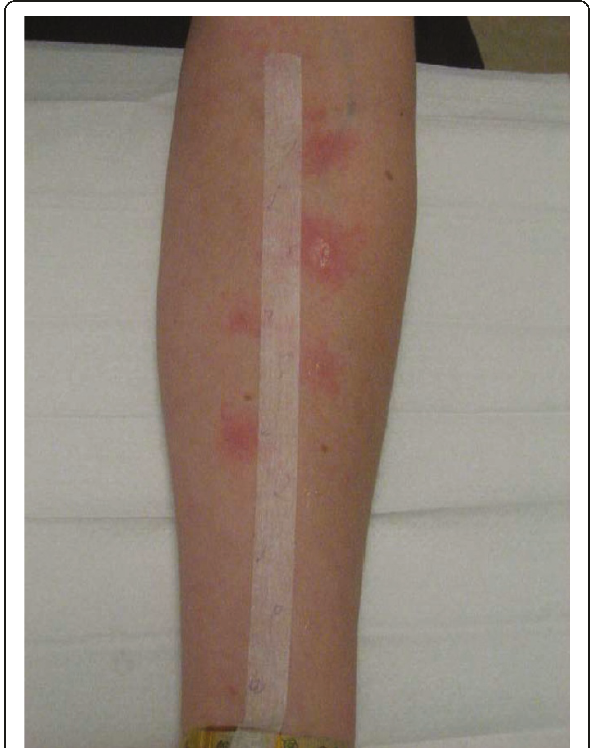
Figure 11 Skin prick test with evaluation of wheal and flare reaction on the skin at the site of allergen deposition